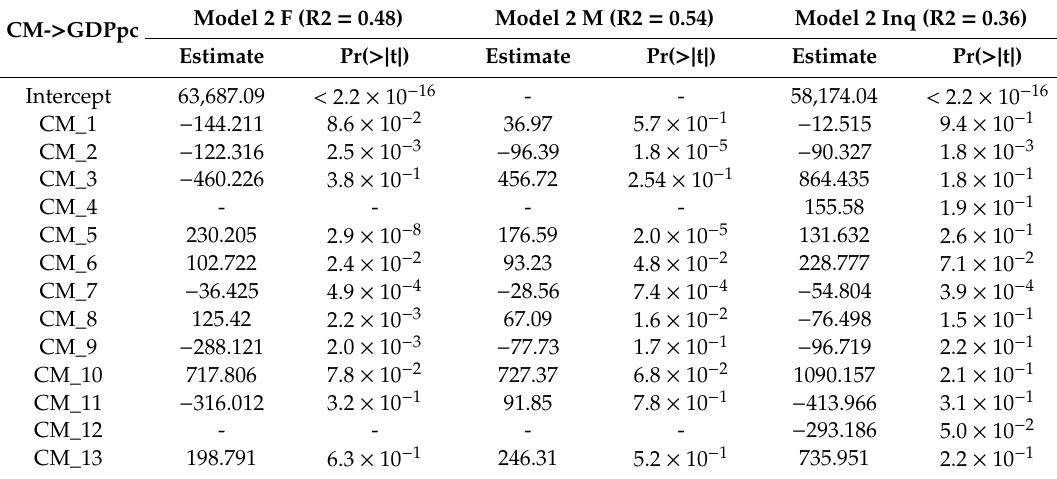
Table 6. Regression analysis output—a multivariate approach to the relations of mortality causes and economic